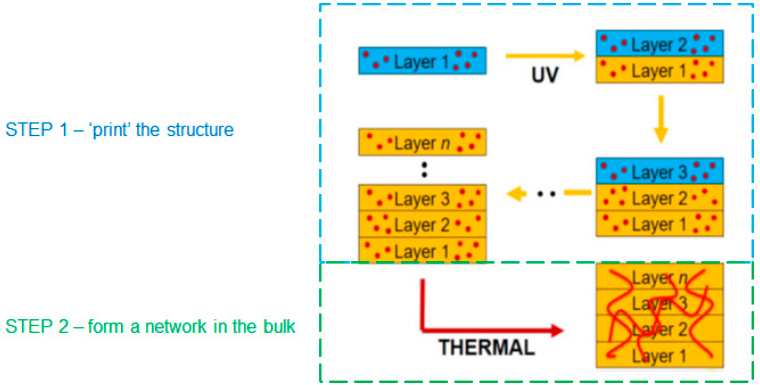
Figure 1. Schematic of the two ‐ stage cure process.